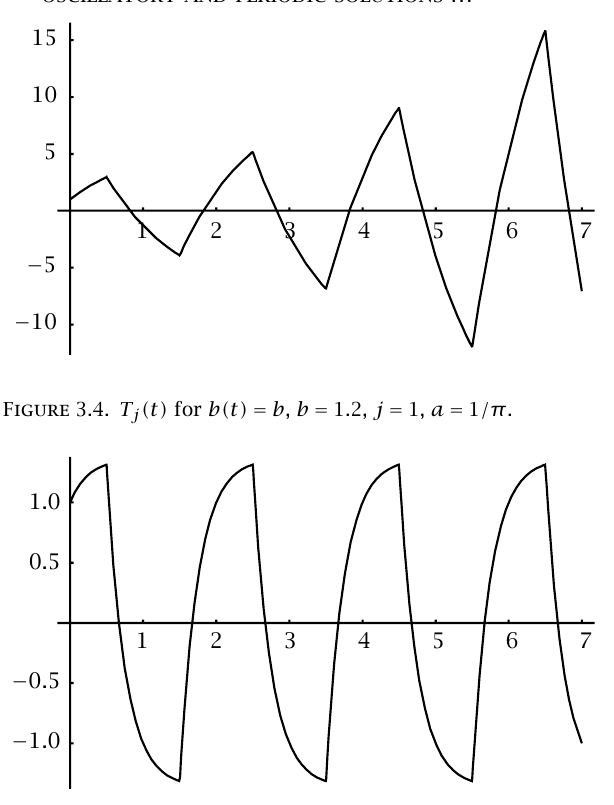
Figure 3.5 . T j (t) for b(t) = b , b = cosh [ 2 ] , j = 2, a = 1 /π .